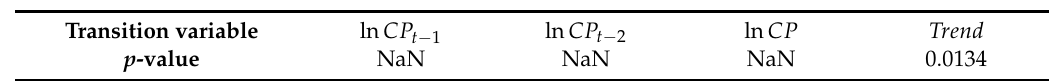
Table 5. Result of nonlinear effect.